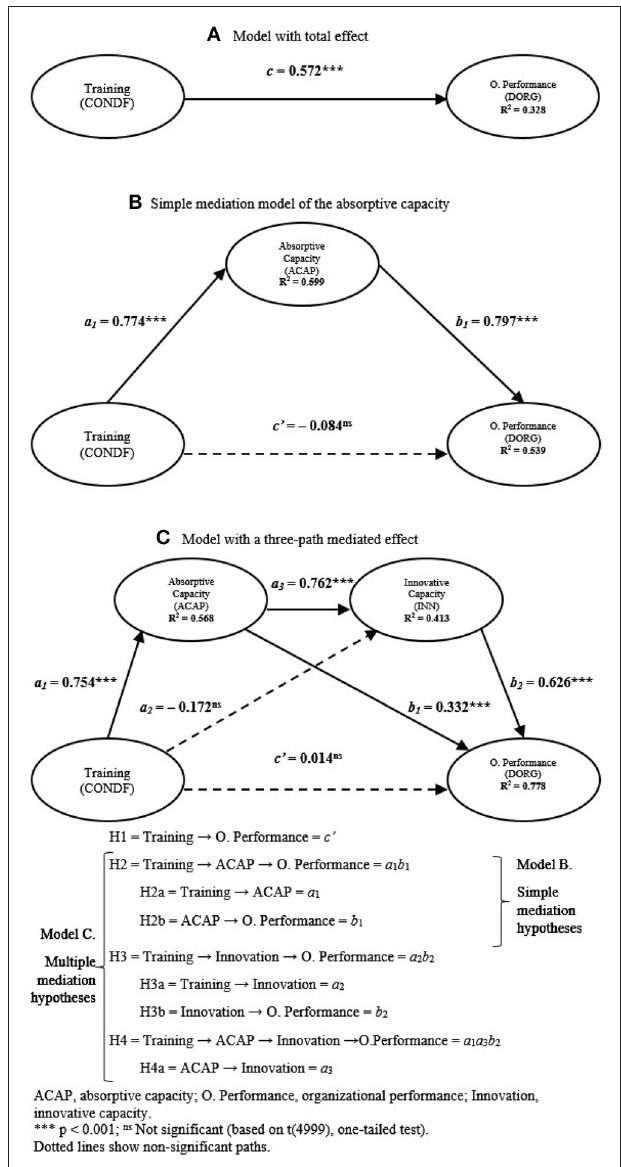
FIGURE 2 | Structural models results: simple and three-path mediation models. (A) Model with total effect. (B) Simple mediation model of the absorptive capacity. (C) Model with a three-path mediated effect.